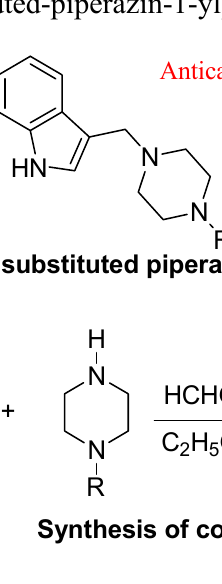
Figure 30. Hybrids of indole and barbituric